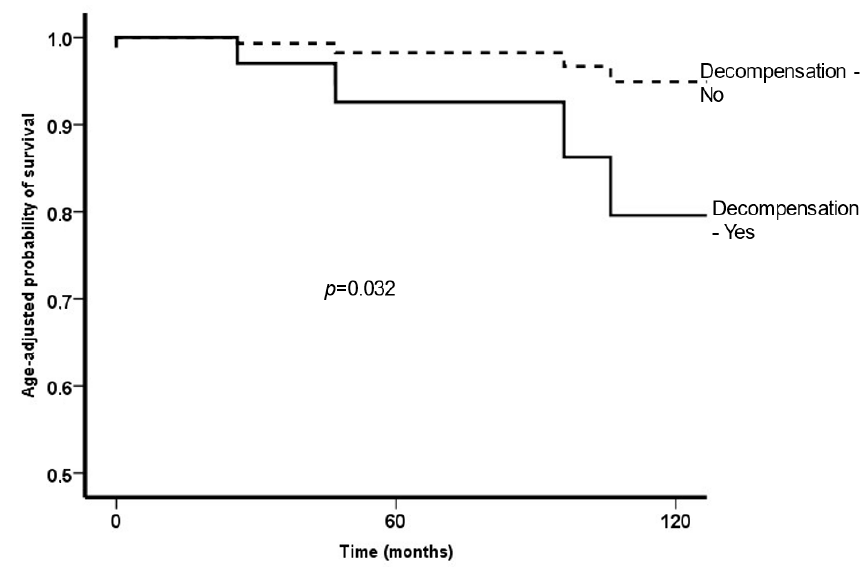
Figure 4. Age-adjusted survival according to development of decompensation.